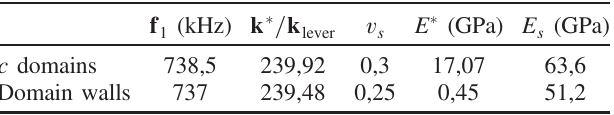
TABLE II. Young ’ s modulus of BaTiO 3 based on the literature [50] ( E ) and experimental results for c domains of BaTiO 3 as s used to calibrate the Young ’ s modulus of the tip ( E domain walls, all the experimental values and the derived values of the Young ’ s